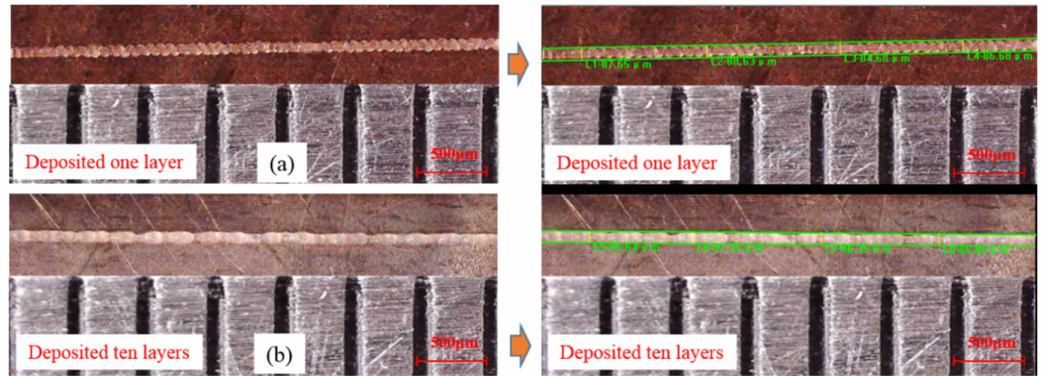
Figure 14. The deposited lines by wax droplets on a copper clad plate: ( a ) deposited one layer; ( b ) deposited ten layers.